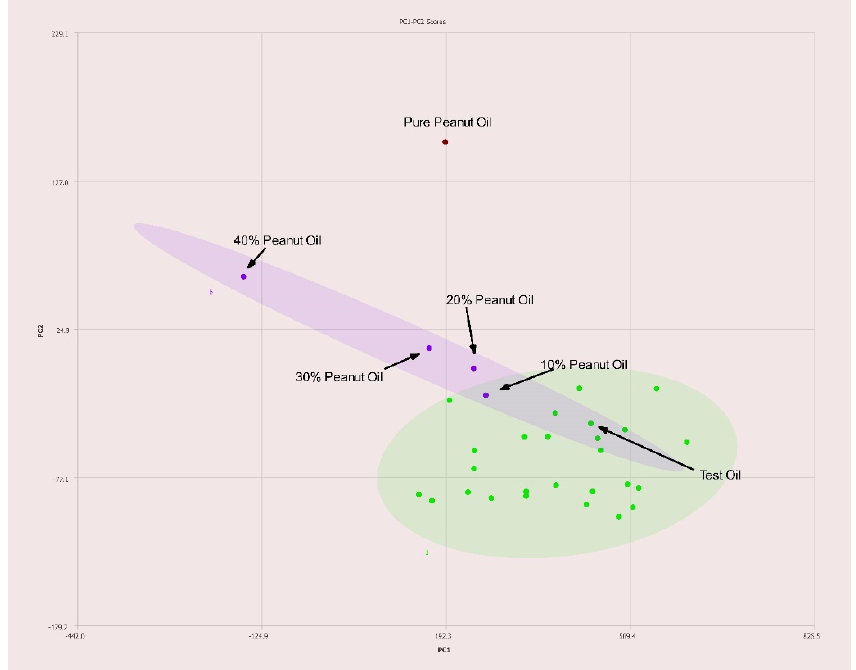
Figure 8. PC1–PC2 plot of 400 MHz 1 H NMR spectra of olive oil adulterated with peanut oil with percentages of adulteration noted. Ellipses represent the 95% confidence interval.